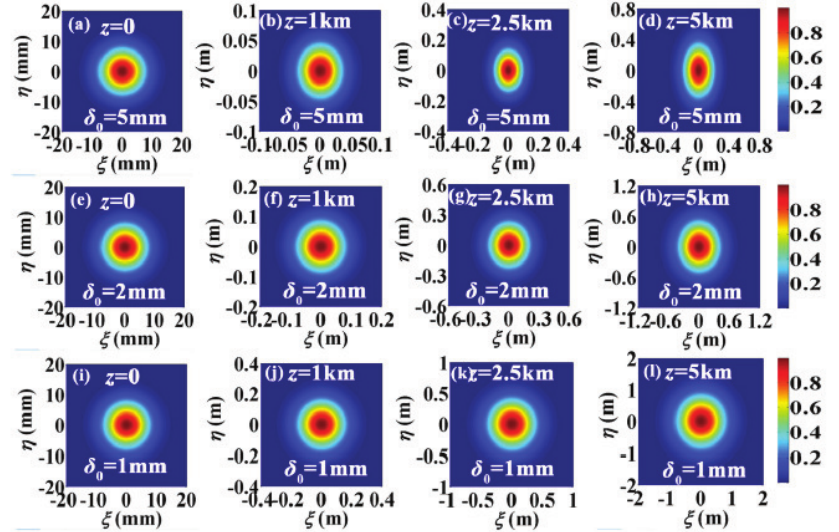
Figure 16. Spectral density S of an electromagnetic Gaussian–Schell model (EM GSM) beam with ( a – d ) high; ( c – h ) intermediate and ( i – l ) low values of the typical coherence width δ 0 , on propagation through an anisotropic turbulence in a horizontal direction, at specified distances. Reprinted with permission from Reference